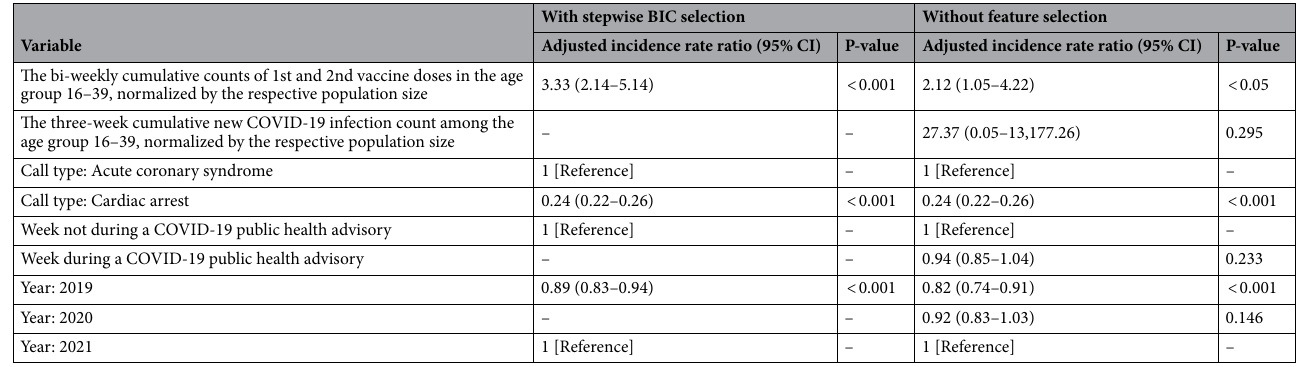
Table 2. Associations with cardiac arrest and acute coronary syndrome calls among those aged 16–39 using a negative binomial regression model, with and without stepwise BIC feature selection. BIC Bayesian information criterion, CI confidence interval, COVID‑19 coronavirus disease 2019.